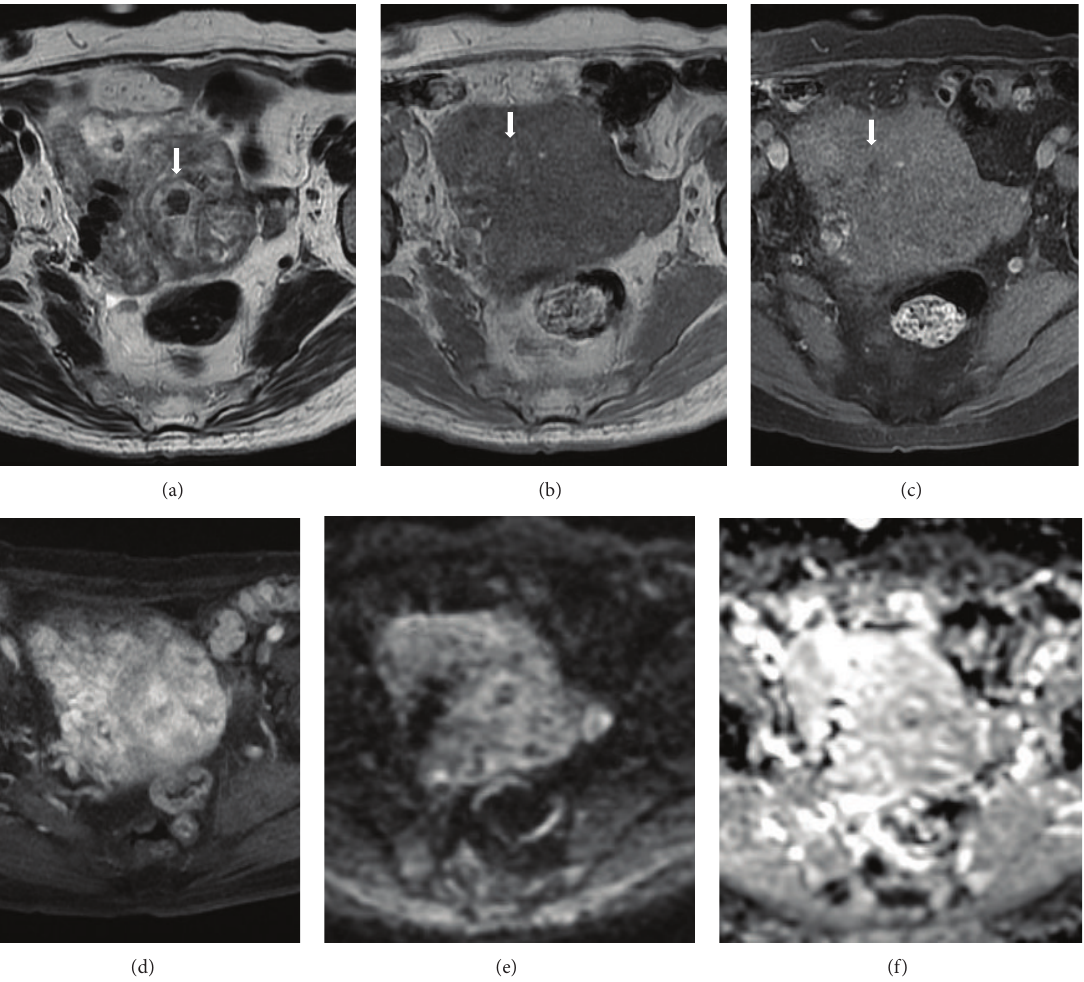
Figure 3: On MR images, the uterine tumor, approximately 13×7×6 cm in size, extensively involved the myometrium as a poorly demarcated diffuse lesion. (a) Axial T2-weighted image showed the lesion involving a few hypointense nodules (arrow) as having inhomogeneous high signal intensity (SI). (b) Axial T1-weighted image showed the lesion with a number of hyperintense tiny foci (arrow) as having low SI similar to that of the myometrium. (c) On the axial fat-suppressed T1-weighted image, the hyperintense foci within the lesion on T1-weighted images were suppressed (arrow), reflecting a lipomatous tumor. (d) On the contrast-enhanced fat-suppressed T1-weighted image, the lesion demonstrated strong contrast enhancement but contained several poorly demarcated hypointense areas, reflecting degenerative or necrotic changes. ((e), (f)) On diffusion-weighted images (e) and the ADC map (f), the lesion showed slightly high SI.